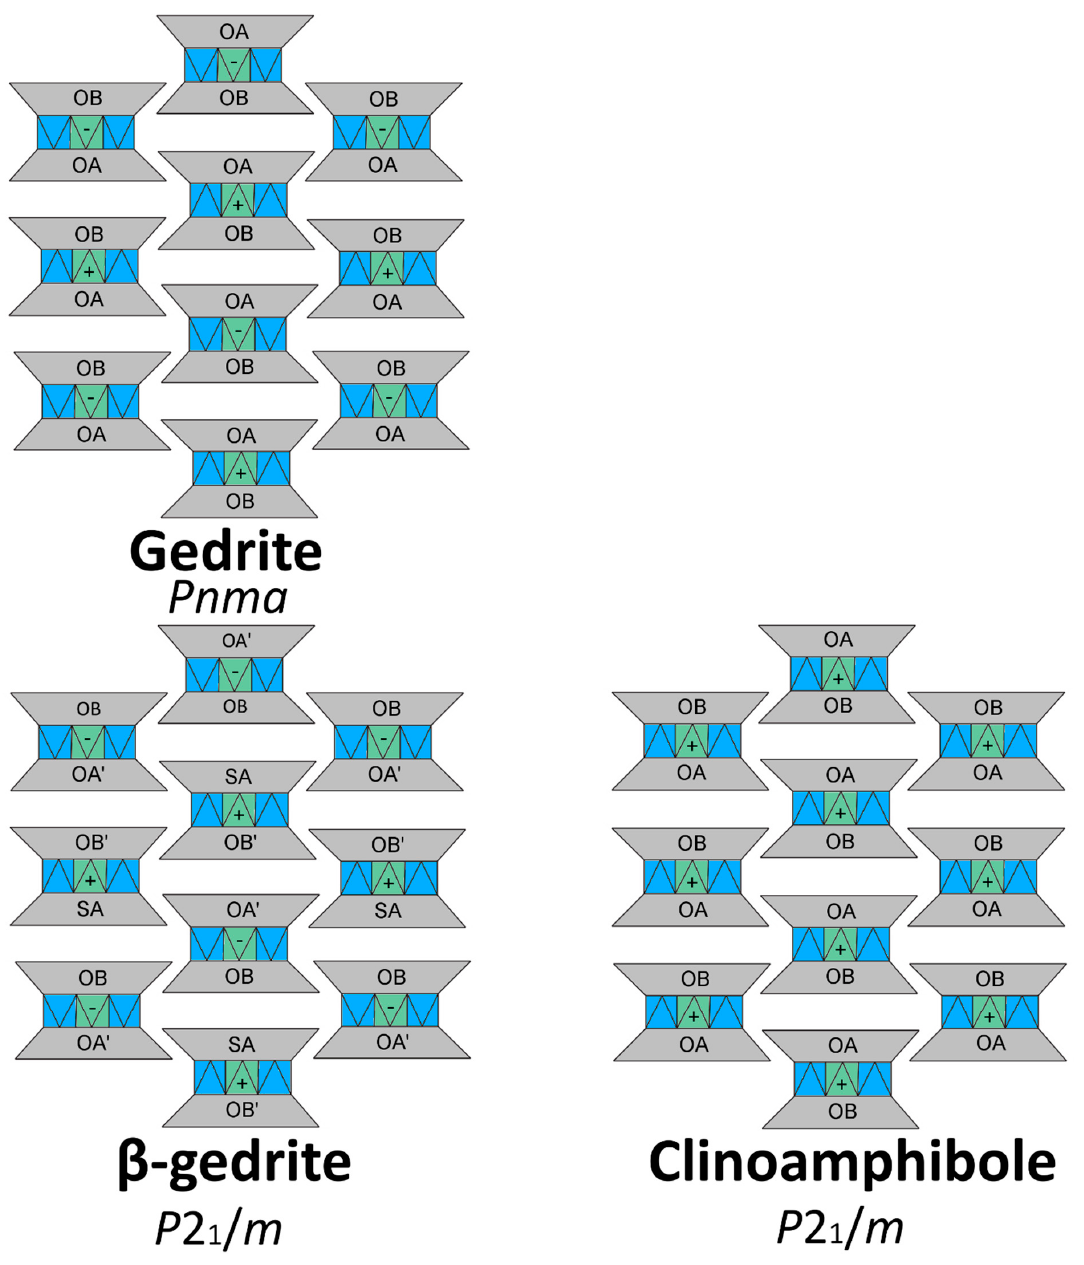
Figure 2. I-beam topological representation of gedrite, β -gedrite and P 2 1 / m clinoamphibole. The I-beam stacking sequence in β -gedrite remains the same as the ambient phase ( + , + , -, -) despite the change in rotation type for the A-chain. The β -gedrite and P 2 1 / m clinoamphiboles are di ff erent structures, as evidenced by their di ff erent stacking sequence.